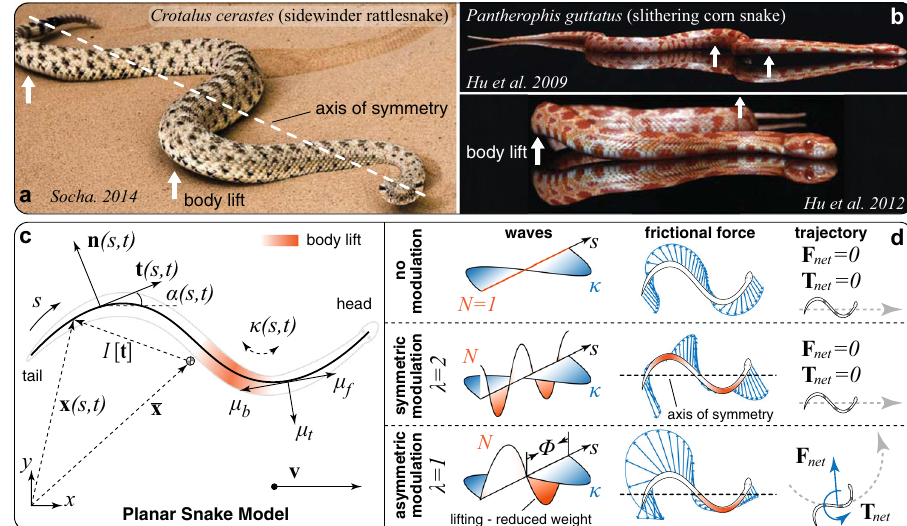
Fig. 1 Examples of biological snakes employing a lifting body wave in addition to lateral undulation. a A sidewinding rattlesnake ( Crotalus cerastes ) asymmetrically lifts up only one side of its body 52 . b A corn snake ( Pantherophis guttatus ) slithering on a fl at surface and symmetrically lifting regions of high lateral curvature on both sides of its body 13, 14 . c Schematic of the planar snake model. Note that the arc-length s goes from tail to head to retain consistency with 13, 14 . The local position x is related to the center of mass x through zero-mean integration function I [ t ] (Methods). d Three different stereotypes of body lifting. Top: Zero body lifting leads to classical undulatory planar gaits. Middle: Symmetric body lifting, the snake symmetrically lifts both sides of its body 13, 21 . Bottom: Asymmetric body lifting, the snake lifts one side of its body off the ground and maintains the other in contact with the ground. Asymmetric lifting has been well-documented in sidewinding snakes 2, 21, 22, 26, 27 . Net forces and torques acting on the snake over one undulation R R R R 1 1 1 1 period are computed via F ¼ ð x (cid:3) x Þ ´ F ð s ; t Þ dsdt , F ð s ; t Þ dsdt and T net ¼ net 0 0 0 0